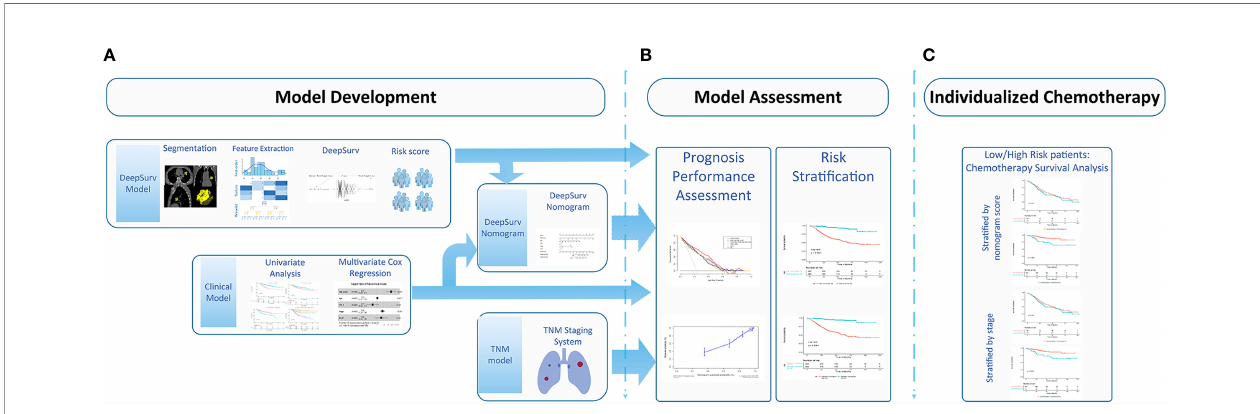
FIGURE 2 | Work fl ow for developing the DeepSurv nomograma. (A) Computed tomography (CT) image segmentation was performed using semiautomatic segmentation on the radiomics prototype software (Radiomics, Frontier, Siemens); (B) The radiomic features from the volumes of interest were then computed with CT images on a prototype, including fi rst-order statistics, shape, size, and texture features; (C) DeepSurv was developed based on the radiomic features. The risk score was calculated for each patient, and the patients were strati fi ed into high- and low- risk groups according to the median risk score; DeepSurv nomogram for 3 and 5-year overall survival (OS) was generated for non-small cell lung cancer (NSCLC) patients. Calibration curves are drawn for the DeepSurv nomogram-predicted and actual survival of patients. The risk strati fi cation could be used to guide individualized adjuvant chemotherapy for high-risk